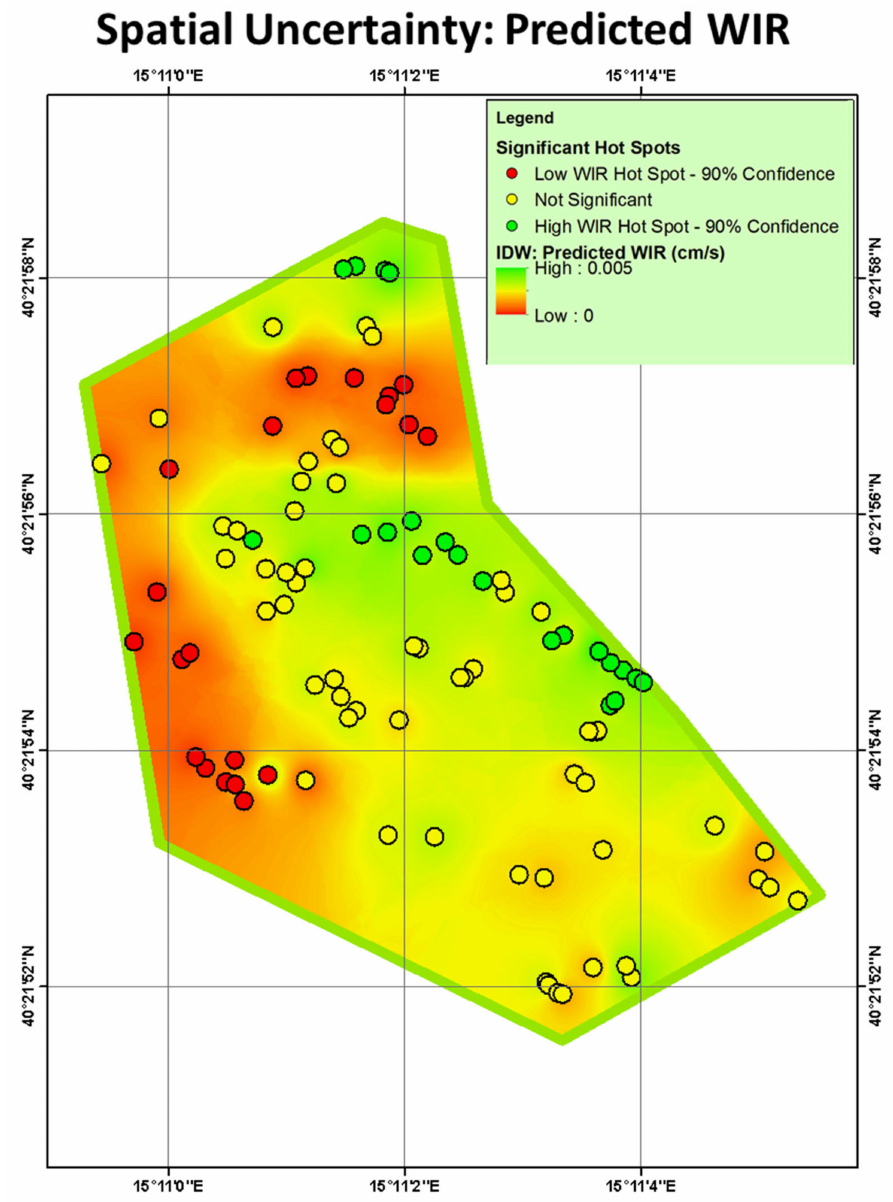
Figure 19. Spatial uncertainty of the predicted